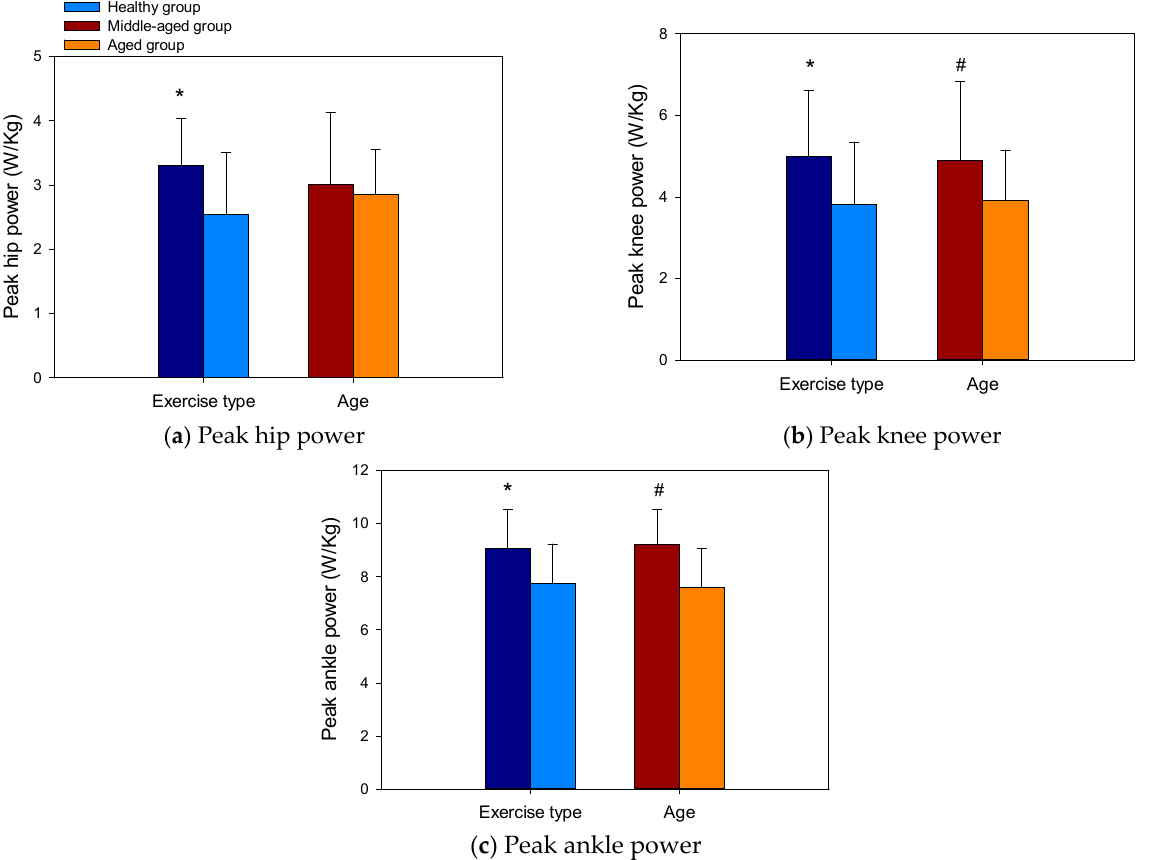
Figure 1. Peak hip, knee and ankle power. Note: * indicates a significant difference between age factor. # indicates a significant difference between exercise type factor.